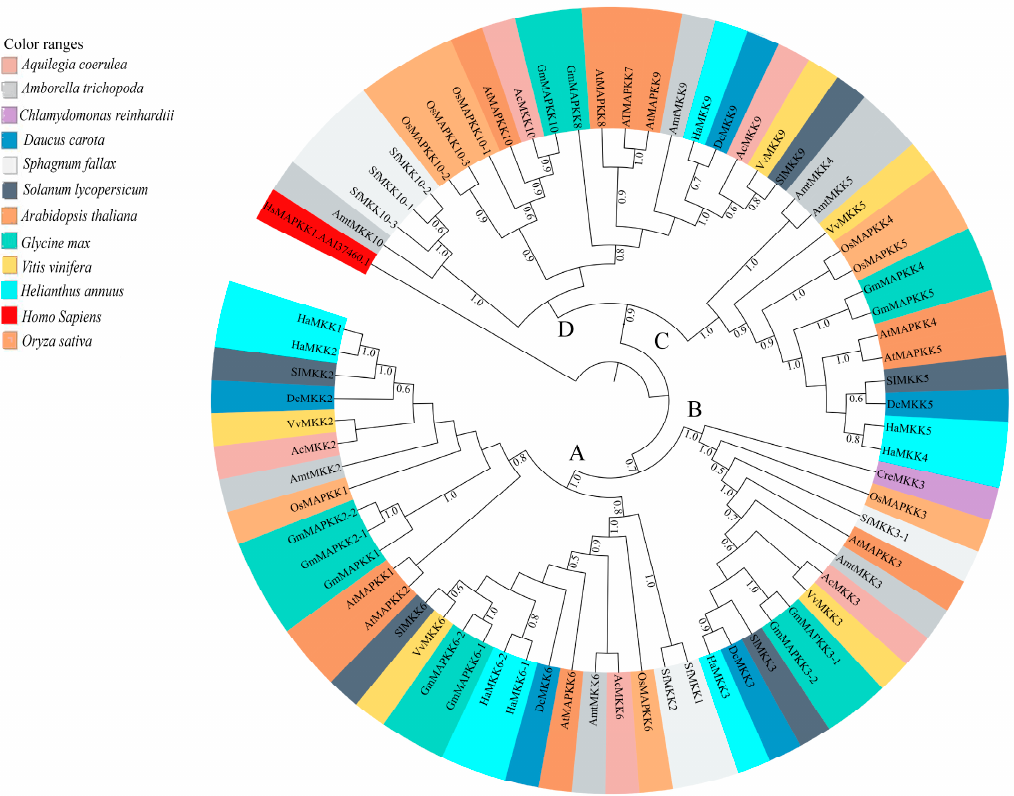
Figure 5. Maximum Likelihood (ML) tree constructed using full-length MKK amino acid sequences from Amborella trichopoda (Amt), Arabidopsis thaliana (At), Aquilegia coerulea (Ac), Chlamydomonas reinhardtii (Cre), Daucus carota (Dc), Glycine max (Gm), Helianthus annuus (Ha), Oryza sativa (Os), Solanum lycopersicum (Sl), and Sphagnum fallax (Sf), and Vitis vinifera (Vv). Phylogenetic analysis with 100 bootstrap replicates was performed in the program MEGA7. Homo sapiens , HsMAPKK1 (GenBank: AAI37460.1) was used as an outgroup. Different species are color-coded, and the MKK clades are labeled A–D. Clade A, B, C, and D members include the previously identified group A (MKK1, MKK2, and MKK6), group B (MKK3), group C (MKK4, MKK5), and group D (MKK7, MKK8, MKK9, and MKK10) members of A. thaliana MKKs, respectively [3,4].